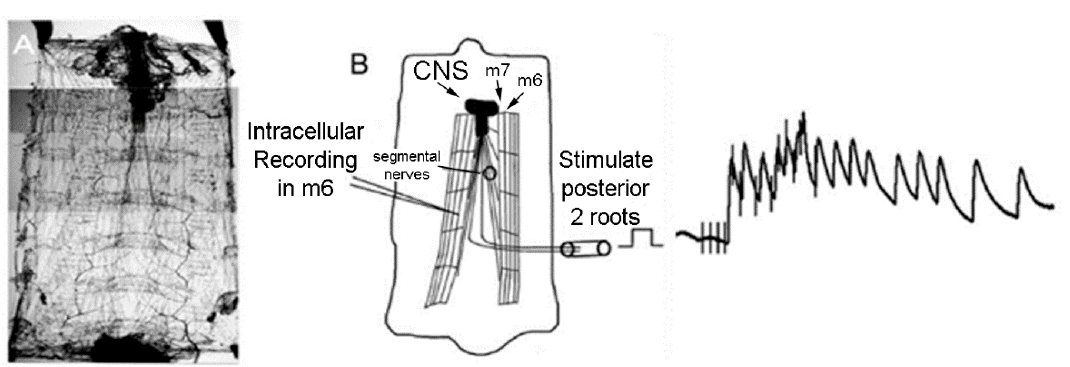
Figure 1. Schematic diagram of the D. melanogaster larva preparation for activating and recording a sensory-CNS-motor nerve circuit. ( A ) The preparation is pinned at the four corners to keep the preparation taut. The ventral abdominal muscle, m6, was used in this study. The ventral abdominal muscle m7 is shown as reference. ( B ) The segmental nerves were stimulated by placing the cut nerve roots into the lumen of a suction electrode and recruiting various subsets of sensory neurons. A sample of evoked response recorded with an intracellular electrode in m6 of EJPs, from a stimulus train, is shown.